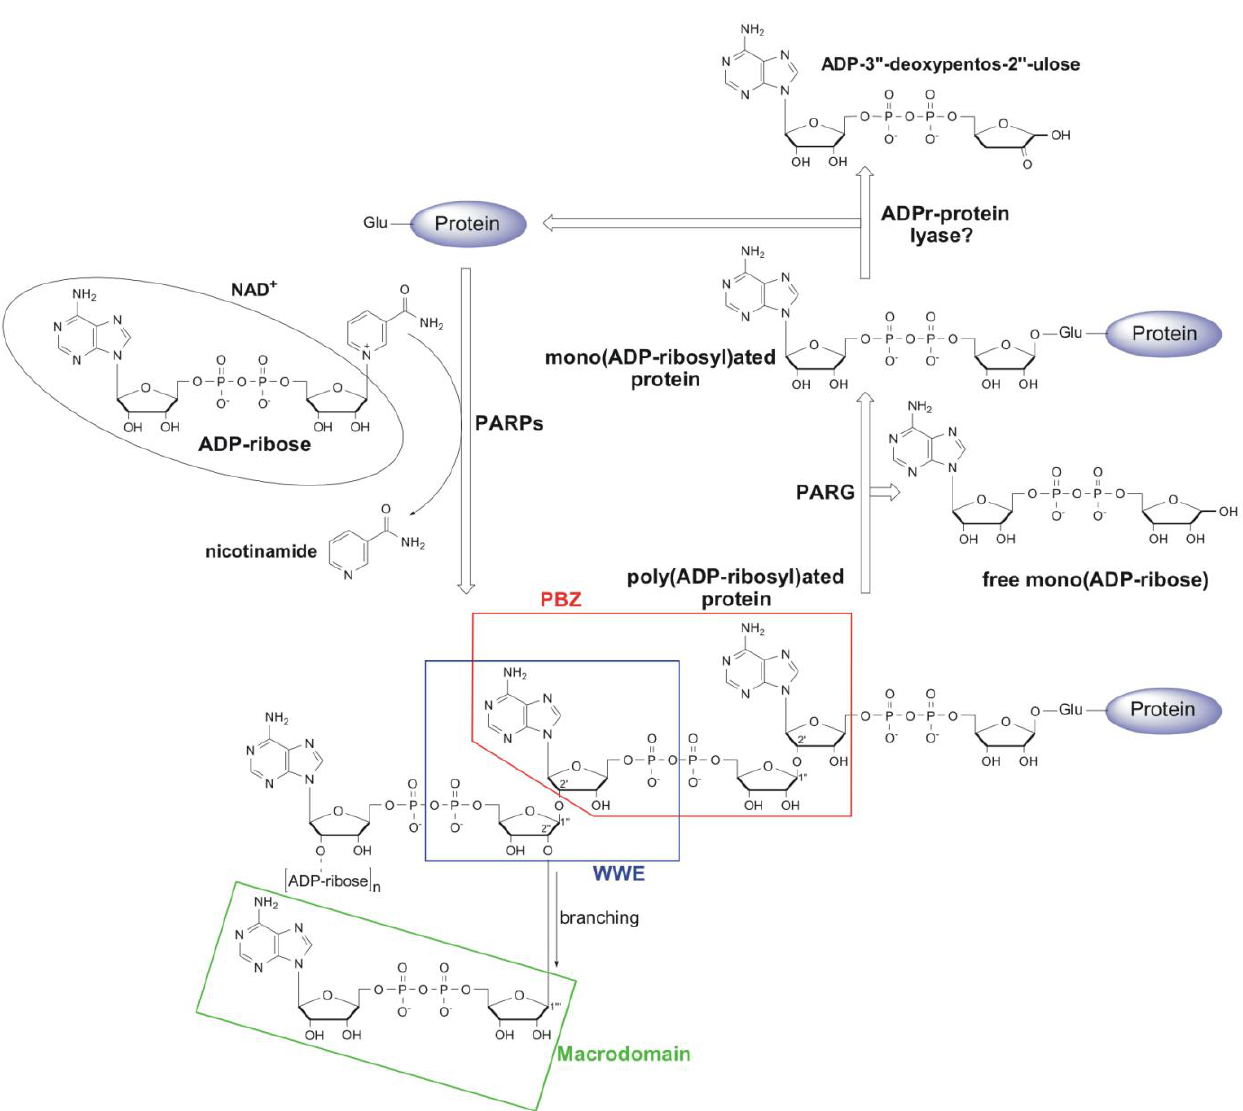
Figure 1. Schematic representation of poly(ADP-ribosyl)ation (PAR) metabolism. PARPs catalyse the transfer of an ADP-ribose moiety from NAD+ to a target protein with the concomitant release of nicotinamide. The first ADP-ribose is attached via an ester linkage to the glutamate on the target protein. The subsequent transfer of additional ADP-ribose molecules through the 2',1''- and 2'',1'''- O -glycosidic bond leads to the synthesis of linear and branched PAR polymers, respectively. PARG cleaves PAR chains and releases mono(ADP-ribose), whilst the proximal ADP-ribose is removed by ADP-ribosyl protein lyase. Regions of PAR recognised by Poly(ADP-Ribose)-Binding Zinc Finger (PBZ), WWE and macrodomain PAR-binding modules are